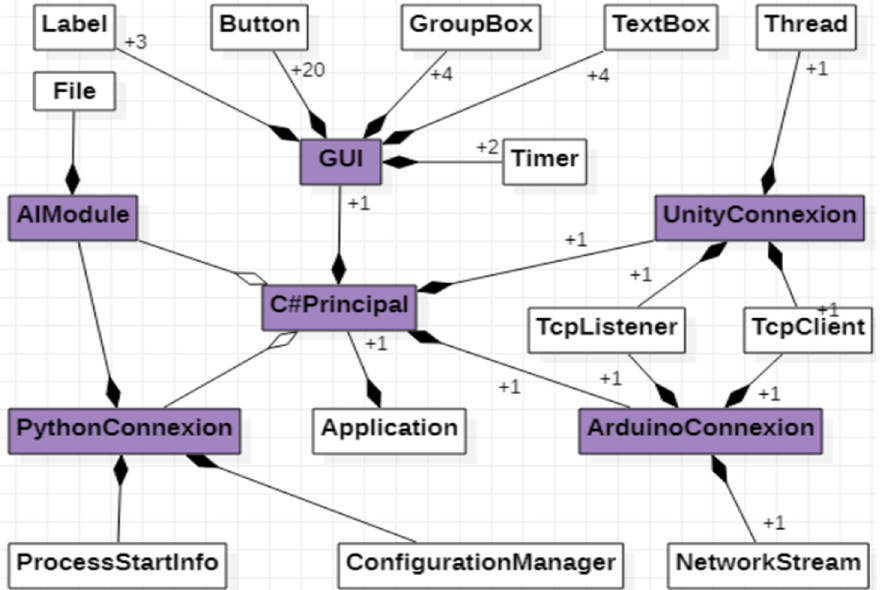
Figure 10. UML class diagram. Graphical User